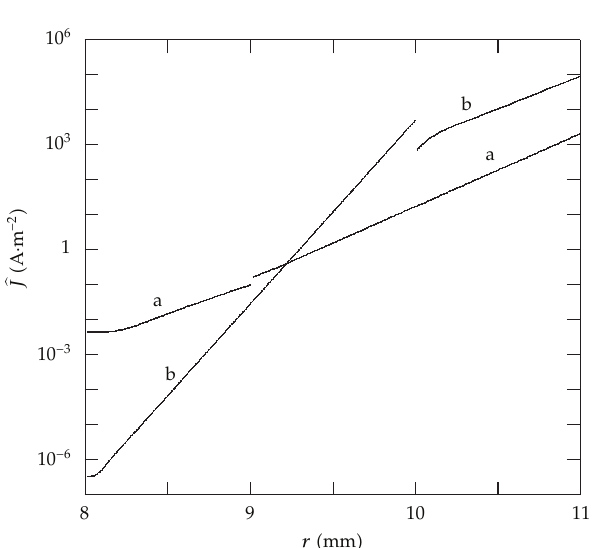
Figure 6: Dependence of the amplitude of phasor J on r in cases a and b of Example 3.4; number of partial conductors N (cid:7) 250.